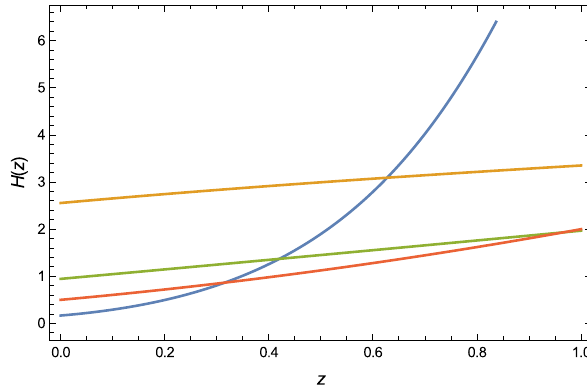
Fig. 2 Evolution of Hubble parameter with respect to redshift for the power-law potential. The corresponding values of the index n are the same as in Fig.